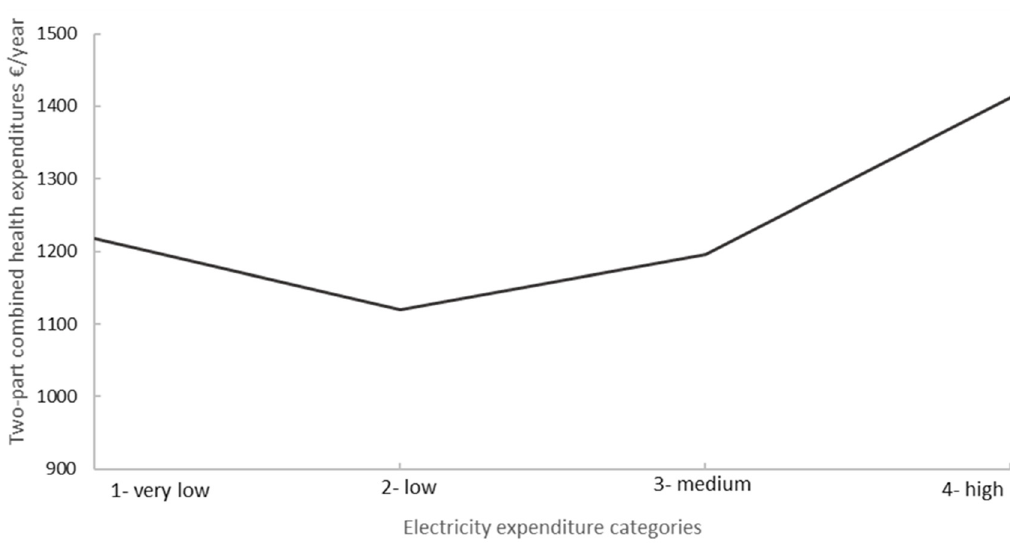
Figure 2. APP for health expenditures by electricity expenditure.